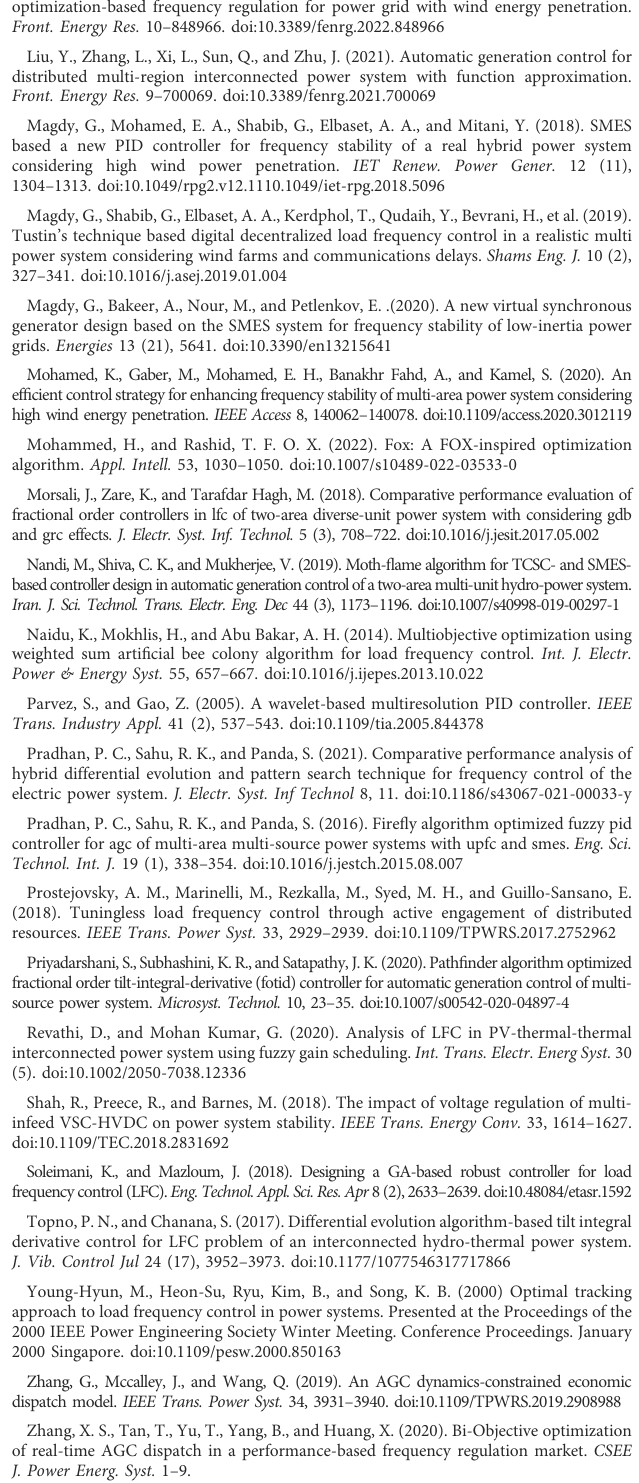
algorithm-based fuzzy-PID controller. Sustainability 13, 12095.